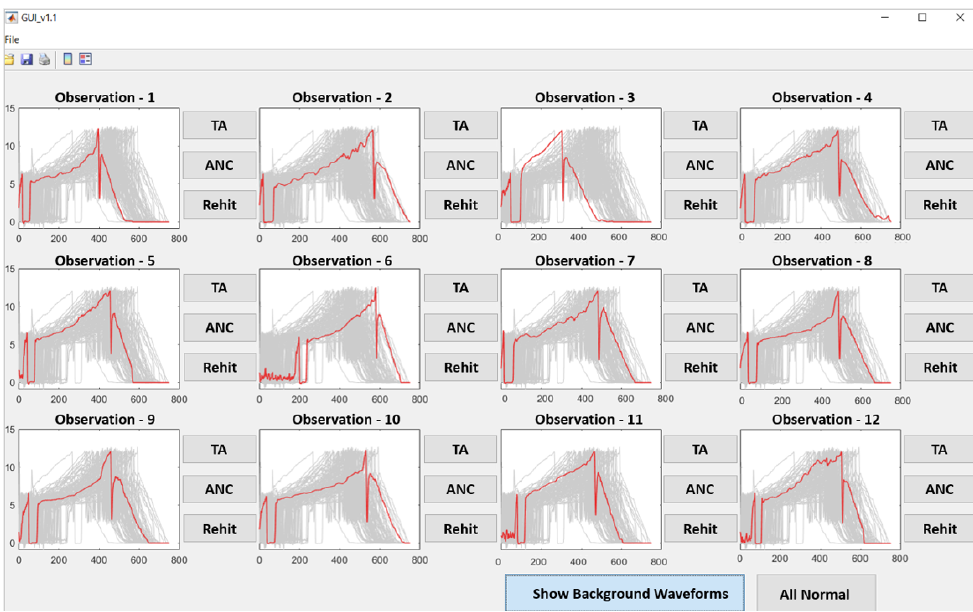
Figure 3. The data labelling dashboard allows users to label batches of 12 normal waveforms at a time. For each displayed waveform, users can select True Anomaly (TA), Anomaly No Concern (ANC), or Re-hit. If all waveforms are normal, the All Normal button labels all 12 observations as